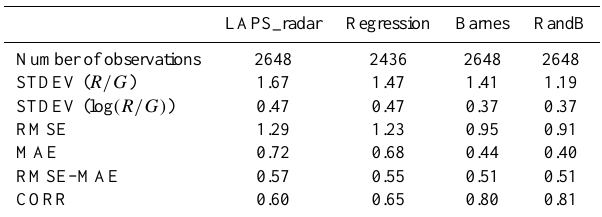
Table 2. Statistical verification results of the different methods for the independent stations data